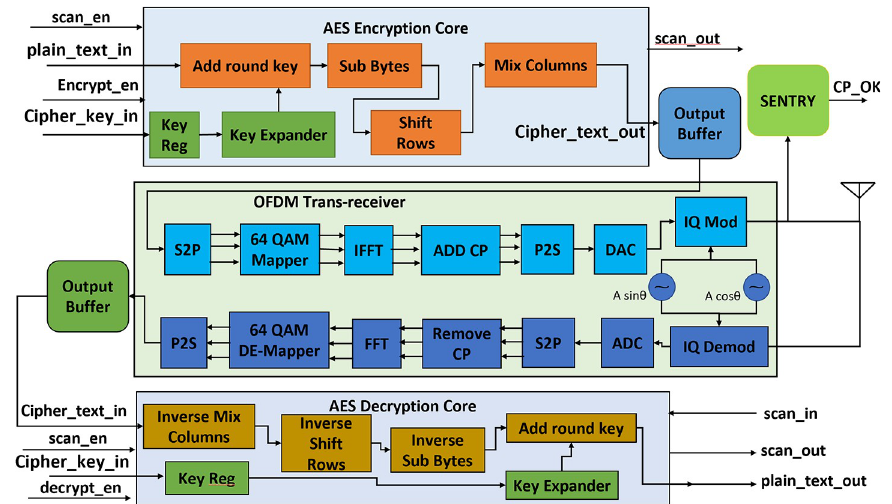
Fig 12. Placement of SENTRY in detailed block diagram of cryptographic IC.